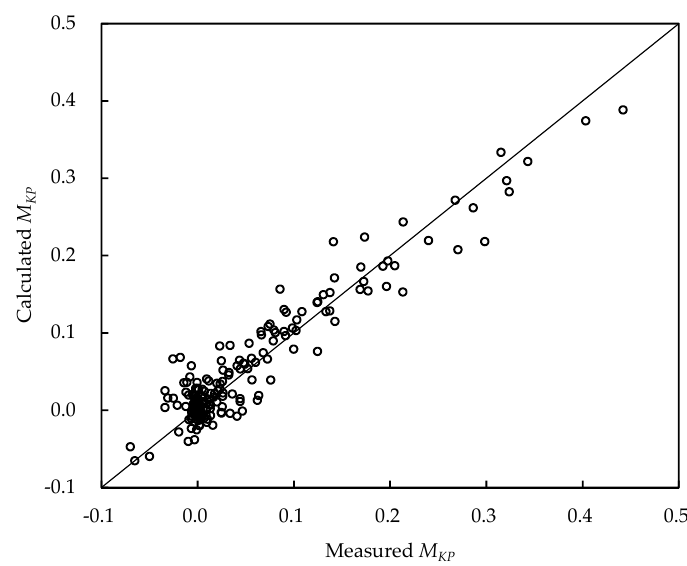
Figure 11. Comparison between the measured and calculated values of M KP .